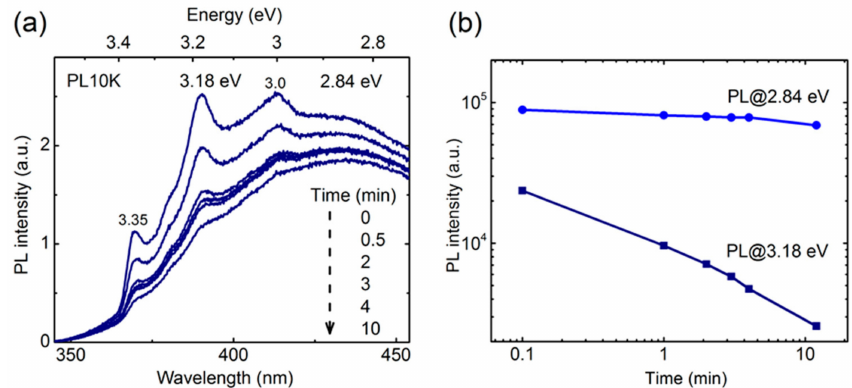
Figure 6. Photoluminescence of nanoporous a-Si:Al (34-week exposure to air): ( a ) Photodegradation of spectral features under UV irradiation revealed by time-lapse PL measurements, ( b ) regression of PL intensity under UV-exposure for the broadband (2.8 eV) and sharp peak (~3.18 eV),